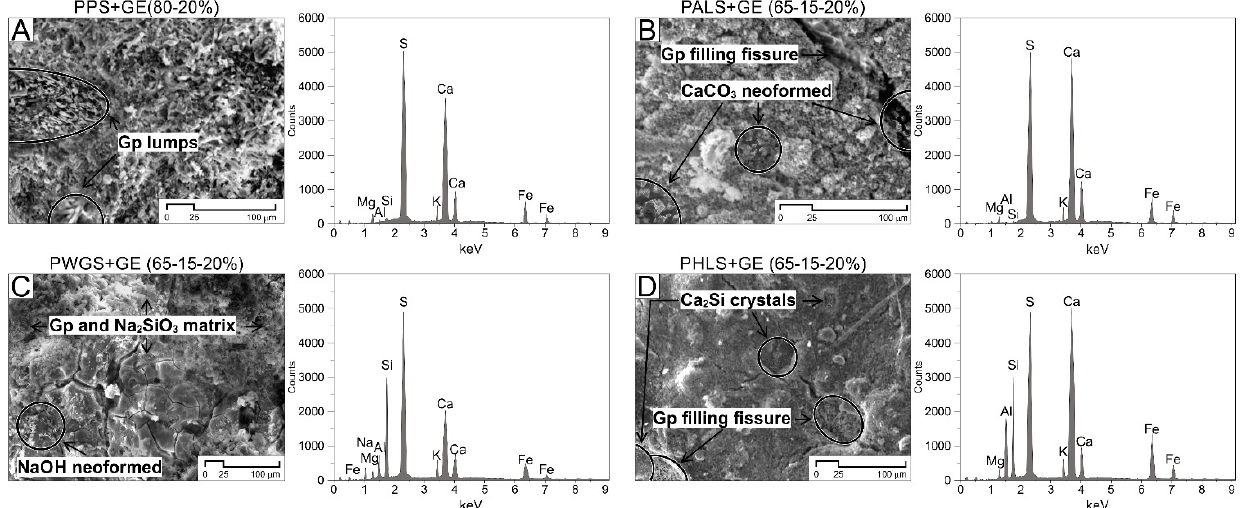
Figure 3. Scanning electron microscopy images corresponding to different pastes with the pigment, GE (Green Earth). The presence of gypsum lumps ( A ), several recrystallizations that are filling cracks ( B , D ) and other characteristic mineralization of the paste’s matrix ( B – D ) are highlighted. The plot of the EDX analysis corresponds to the elemental composition of the matrix.